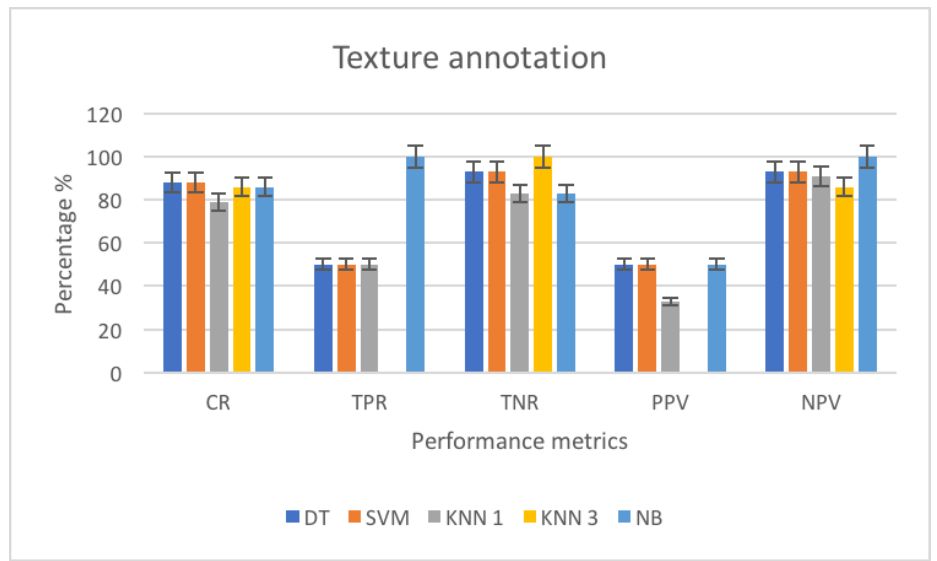
Figure 6. Texture annotation results using decision tree (DT), support vector machine (SVM), K-nearest neighbors (KNN) (k = 1, k = 3) and naive Bayes (NB).